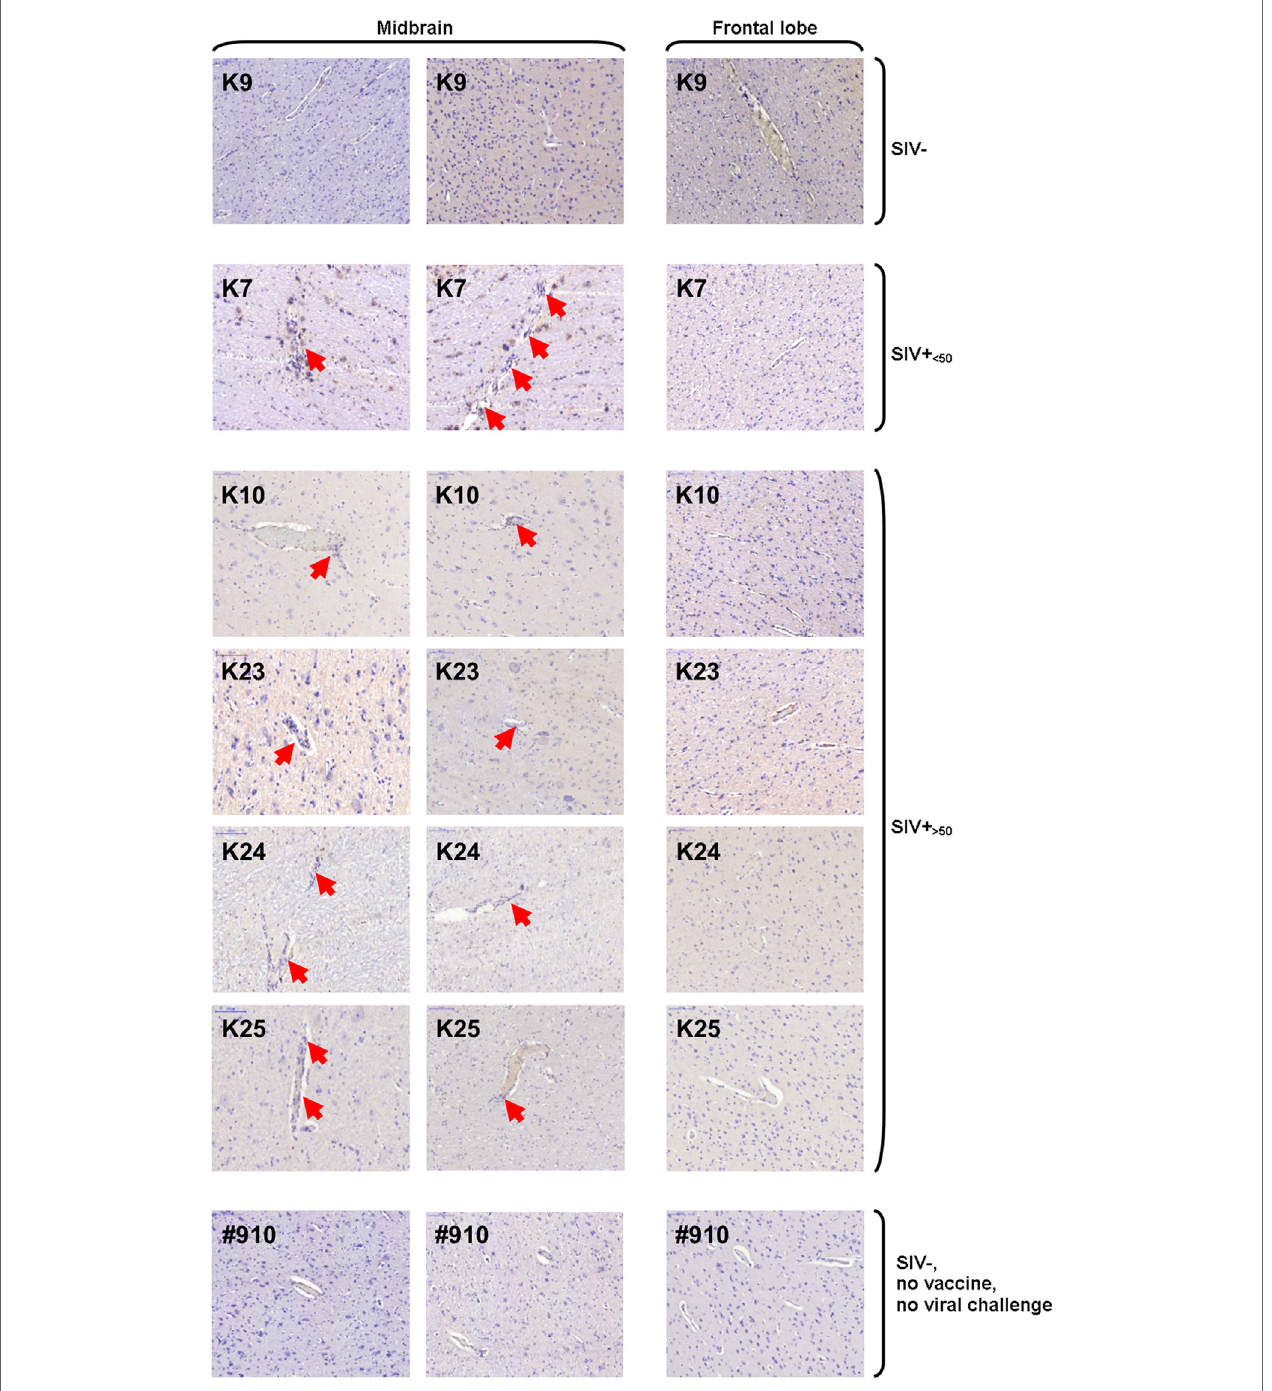
FigUre 7 | hematoxylin staining of midbrain and frontal lobe sections . Images of one representative frontal lobe and two midbrain sections are shown for one of three uninfected [simian immunodeficiency virus (SIV) − ], one of two SIV-infected aviraemic (SIV + < 50 ), four of seven SIV-infected viremic (SIV + > 50 ) animals, and one example of unvaccinated, non-SIV challenge, healthy macaque (#910). Red arrows indicate sites of perivascular cuffing.